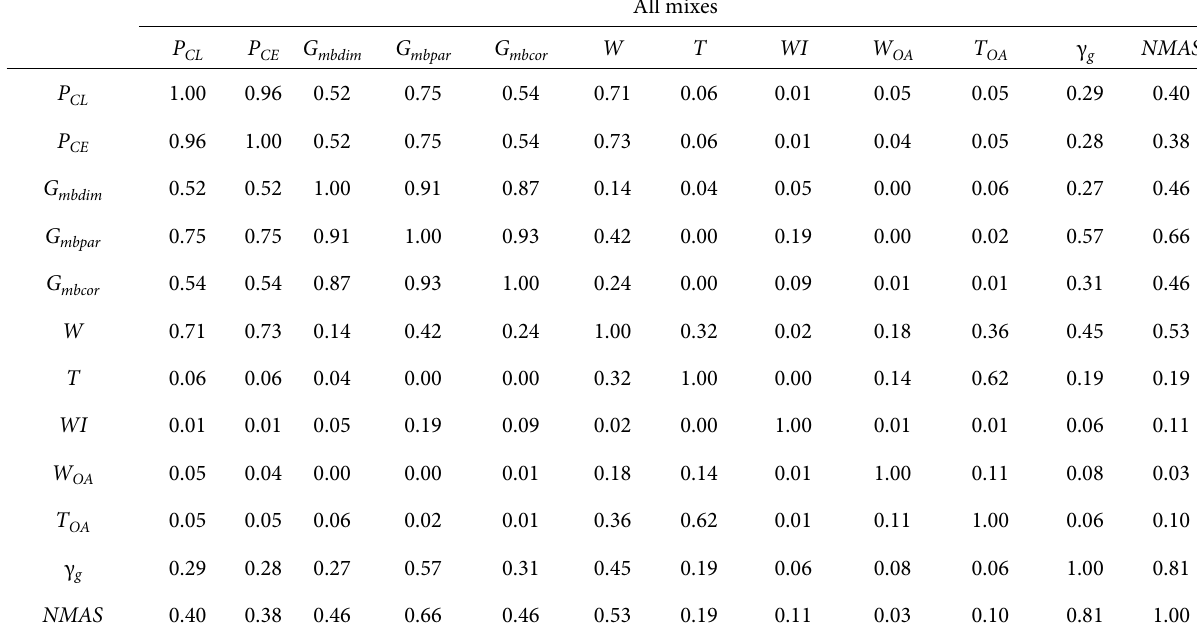
Fig. 3. R -square values for the regressions P J vs. All mixes